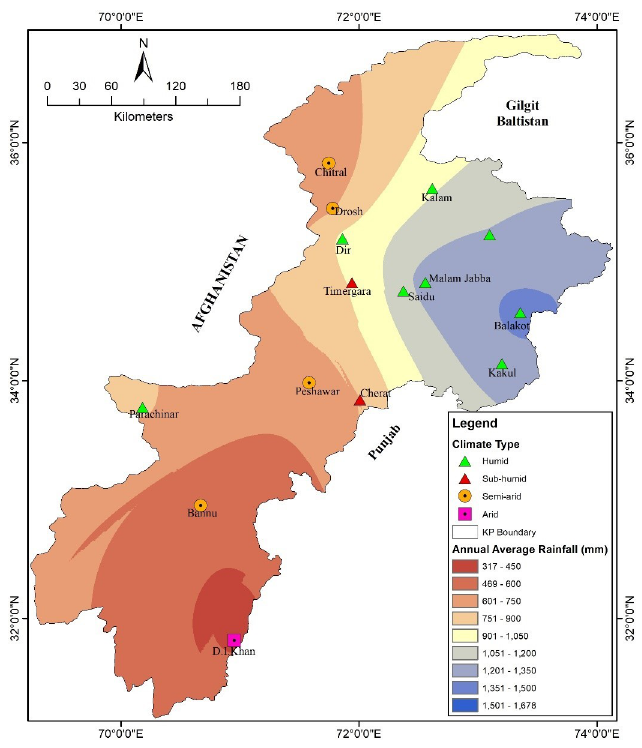
Fig 2. Khyber Pakhtunkhwa, spatial distribution of average annual rainfall and type of climate as per aridity index.